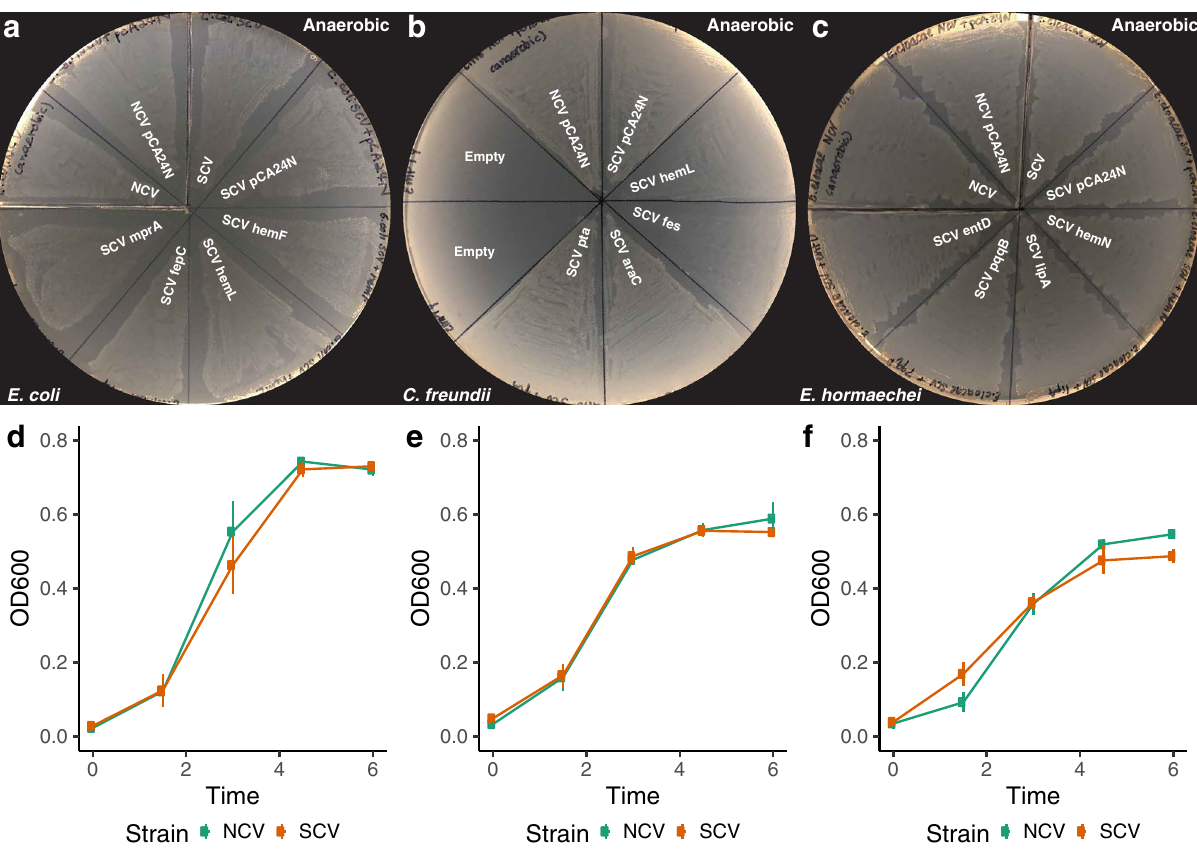
Figure 6. SCV E. coli ( a ), C. freundii ( b ), and E. hormaechei ( c ) isolates grow on minimal media without additional chemical or genetic supplementation in anaerobic conditions. NCV and SCV E. coli ( d ), C. freundii ( e ), and E hormaechei ( f ) co-isolates display similar growth kinetics in anaerobic